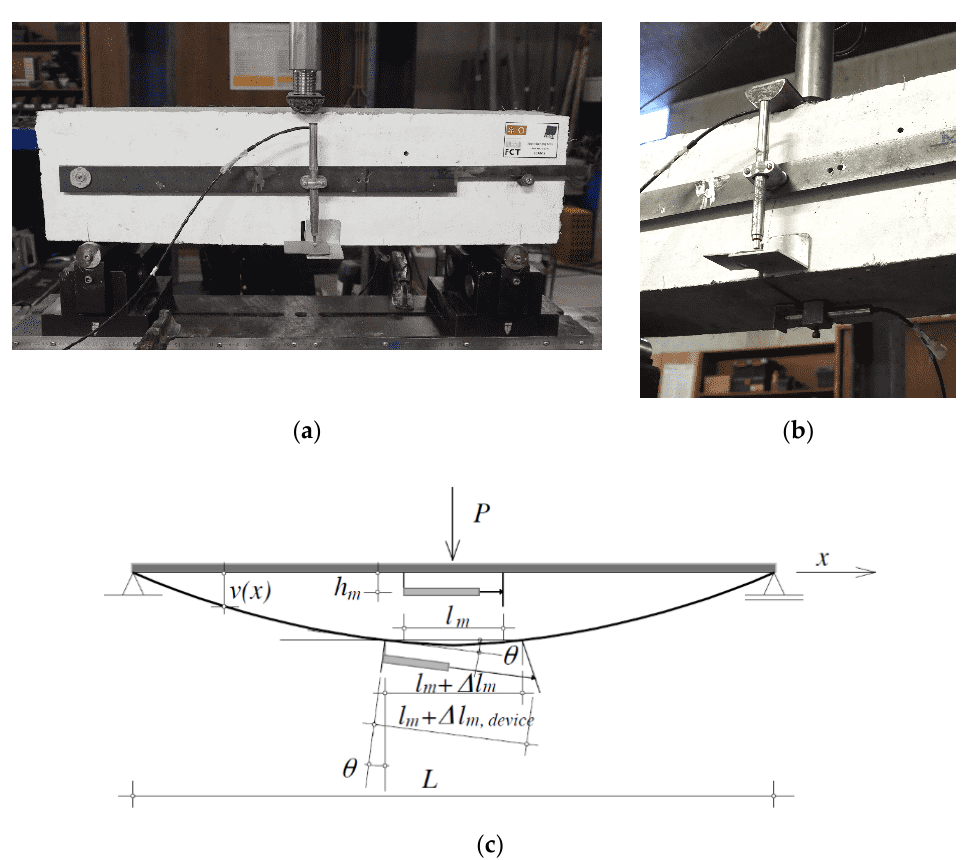
Figure 2. Test setup for three-point notched beam bending test (3PNBBT): ( a ) specimen front view; ( b ) specimen bottom view; and ( c ) measurement of non-linear tensile deformations—initial position of the measurement device and rotation of measurement points caused by rotation of the beam [33].